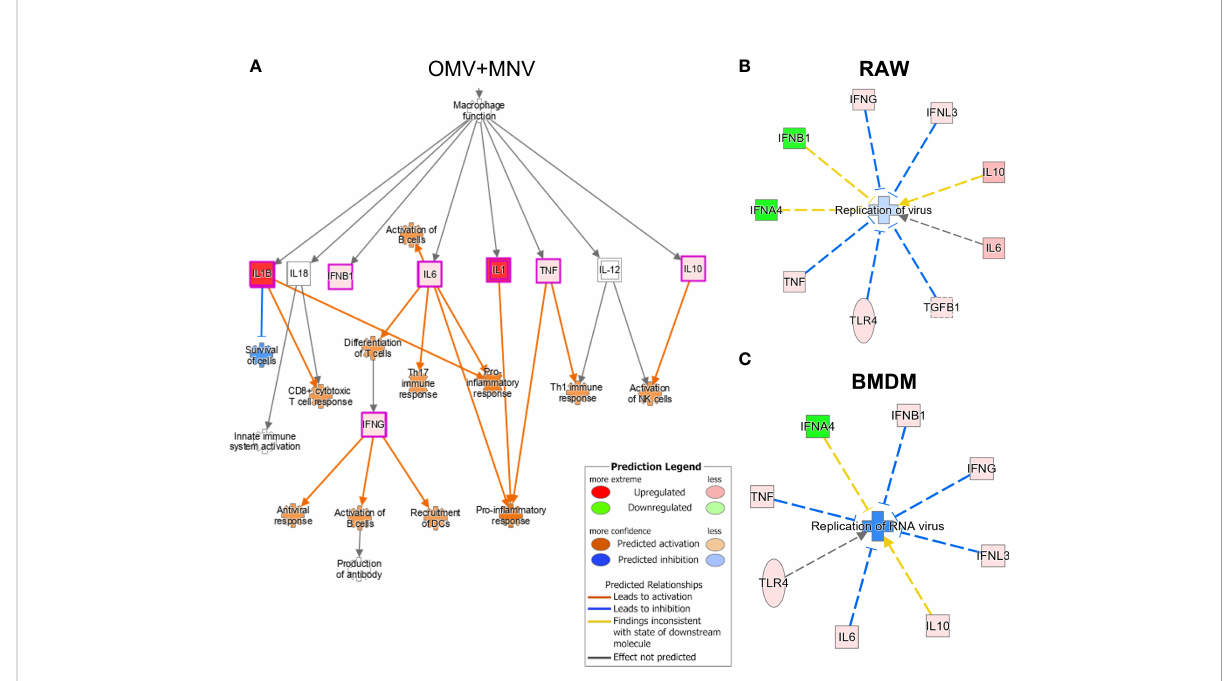
FIGURE 8 Immune pathways induced by OMVs during MNV infection as predicted by Ingenuity Pathway Analysis. Using the transcript expression data generated by Quantigene analysis of MNV and MNV + OMV (5 m g/mL) samples, potential pathways in fl uenced by the presence of OMVs during viral infection were predicted using the IPA software. (A) The presence of OMVs during MNV infection was predicted to activate pro- in fl ammatory, Th17, and Th1 responses and also lead to the activation of both B cells and dendritic cells. (B) IPA analysis of transcript data also predicted OMVs induce pathways related to the inhibition of RNA virus ’ s replication in (B) RAW264.7 macrophages and (C)